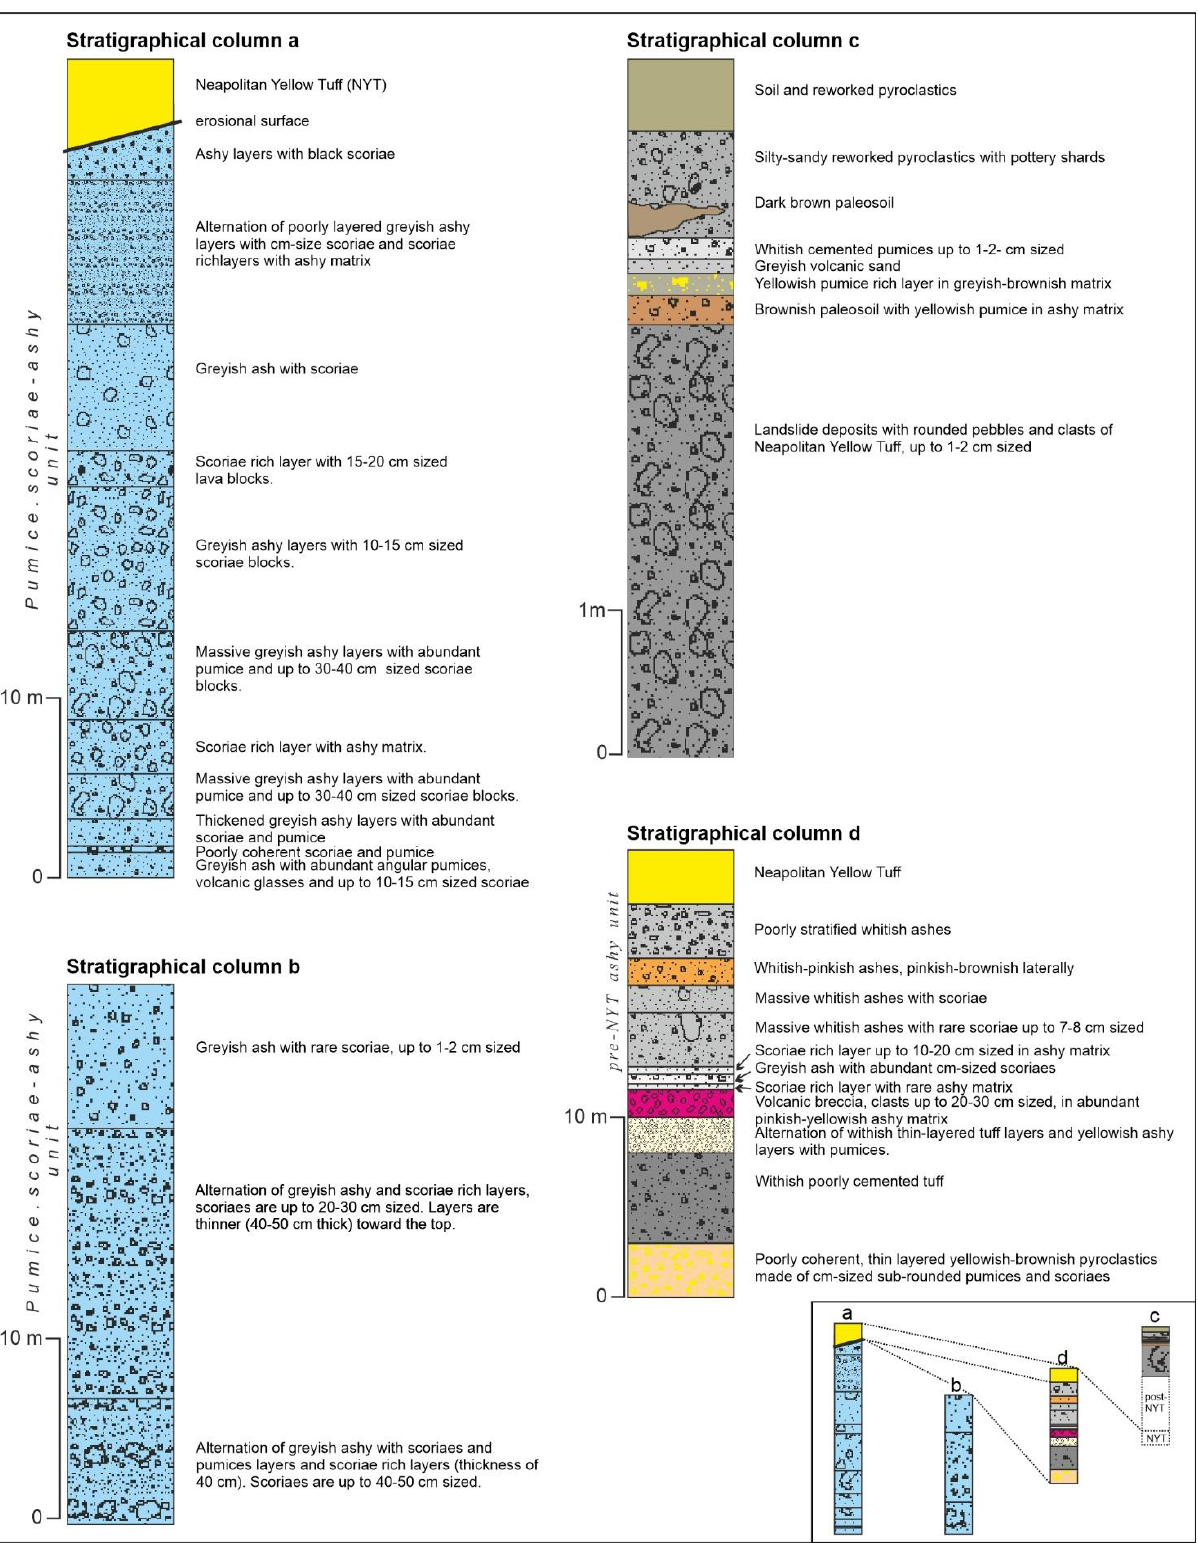
Figure 4. Stratigraphical columns representative of the geological setting of the Coroglio-Trentaremi sea cliff base. Location of stratigraphical column is reported in Figure 3. Inset scheme in the lower right corner of the figure shows stratigraphical correlation between stratigraphical columns.